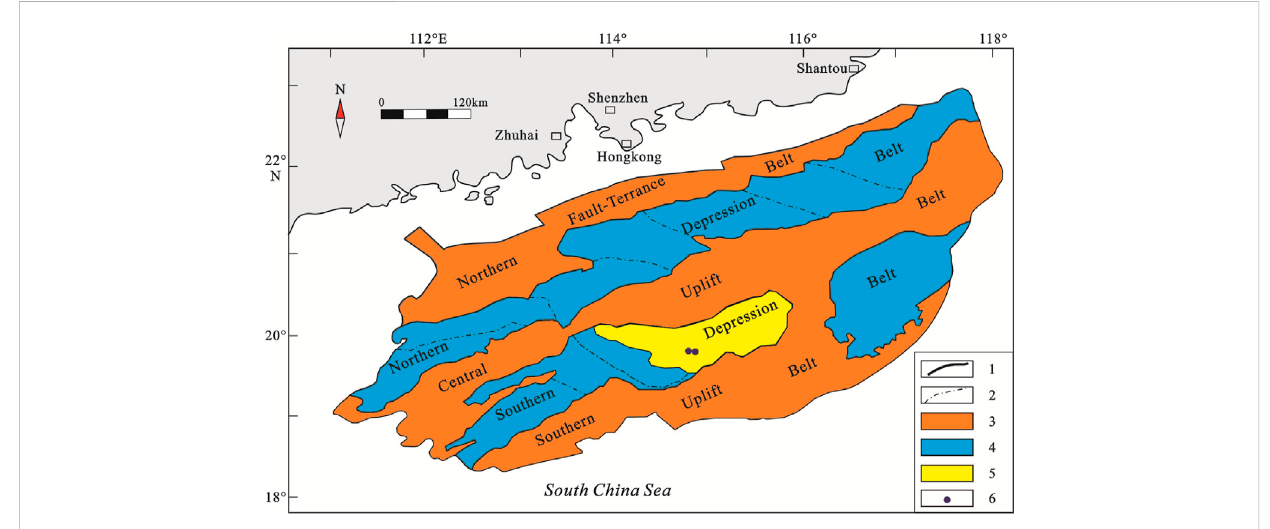
FIGURE 1 The Paleogene tectonic units of the Pearl River Mouth basin (adapted after Wang et al., 2017). 1 boundary of fi rst-order tectonic unit, 2 boundary of second-order tectonic unit, 3 forward direction structure, 4 Negative direction structure, 5 Location of study area, 6 drilling wells